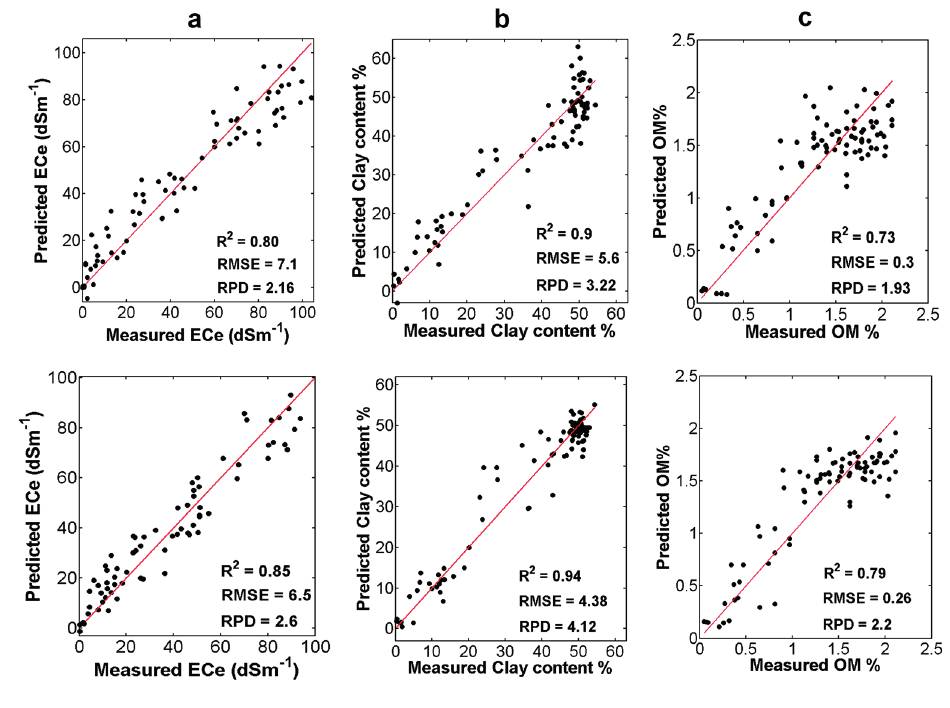
Figure 5. Scatterplots of measured vs. predicted values from PLSR (top) and MARS models (bottom) for: ( a) EC e ; ( b) clay content; and ( c)